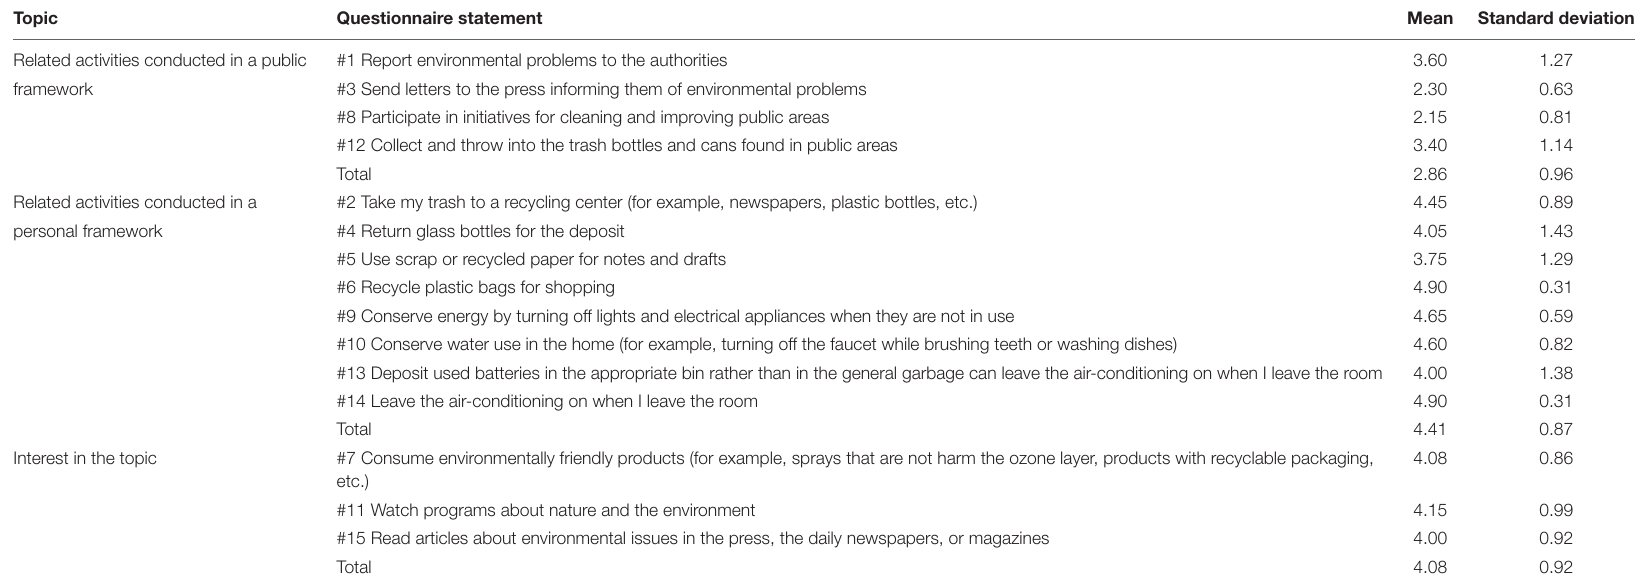
TABLE 3 | Statistical results regarding the pro-environmental behavior.